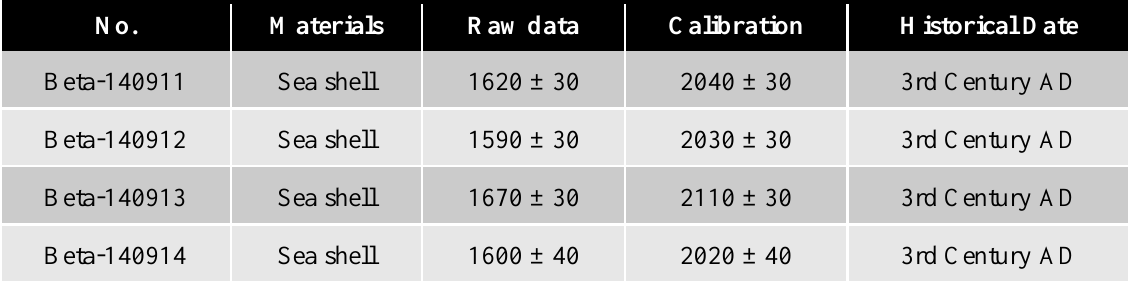
Table 1. Table of AMS (Accelerator Mass Spectrometry) dating.